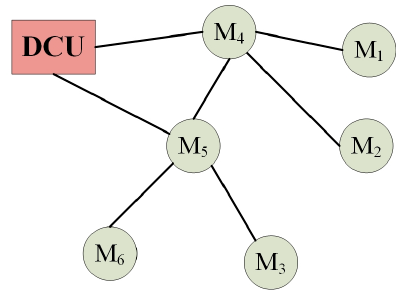
Figure 8. Communication Network of a Simple Six-Meter Case. Table 3. Communication Paths of the Simple Six-Meter Case. Meter